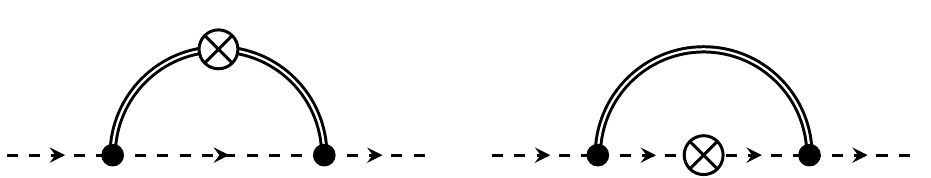
Figure 2. Diagrams that contribute to the scale dependence of the ghost two-point function. Double lines indicate gravitons, dashed lines stand for the Faddeev–Popov ghosts, and the circled cross denotes the regulator insertion ∂ t R k